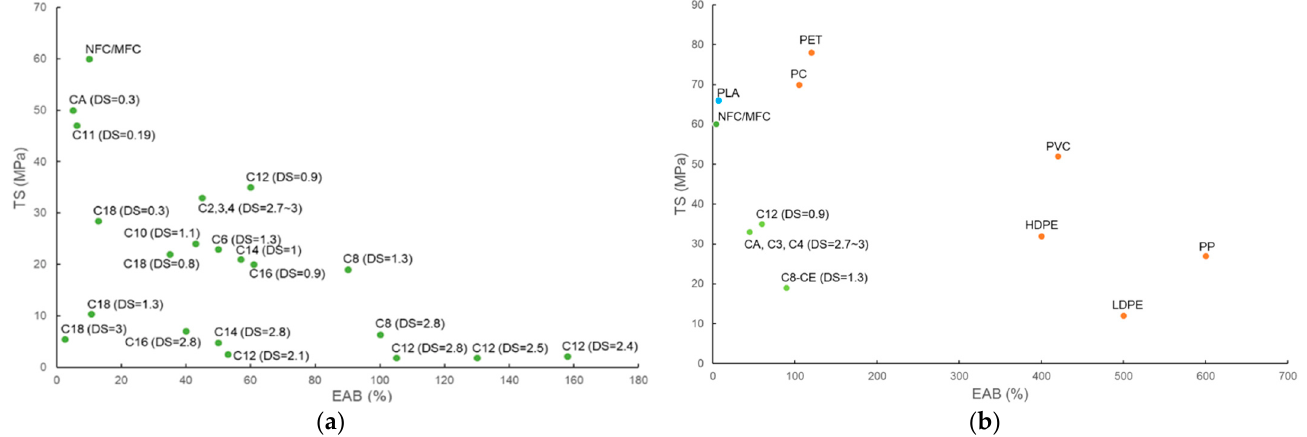
Figure 5. ( a ) Mechanical strength ( ε vs. σ ) of cellulose and cellulose esters with various chain lengths and DS values; ( b ) mechanical strength ( ε vs. σ ) of cellulose and cellulose esters compared with poly(lactic acid) (PLA) and petroleum-derived plastics [116].